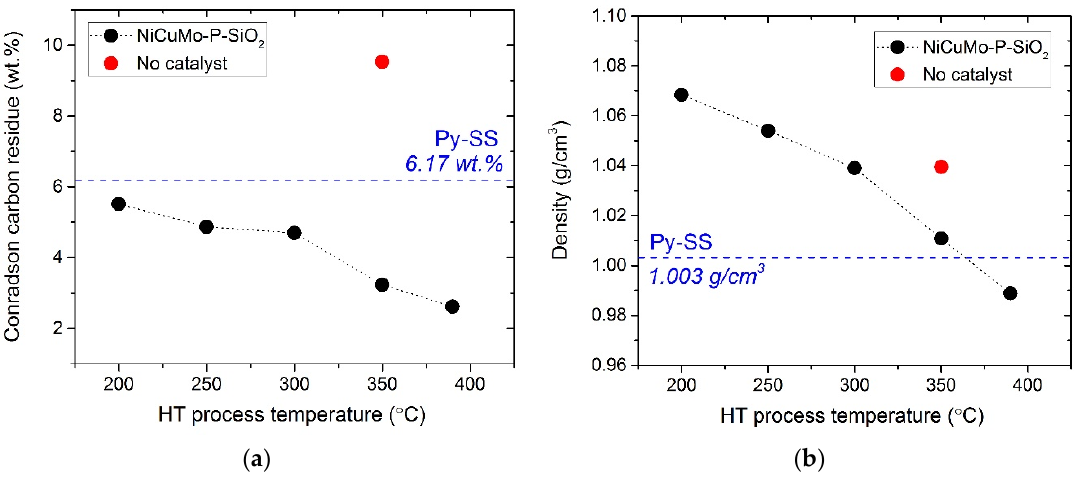
Figure 2. ( a ) Conradson carbon residue (CCR), wt. %; ( b ) Density, g/cm 3 of Py-SS and organic-rich phases (OP) obtained after catalytic and non-catalytic hydrotreatment of Py-SS.